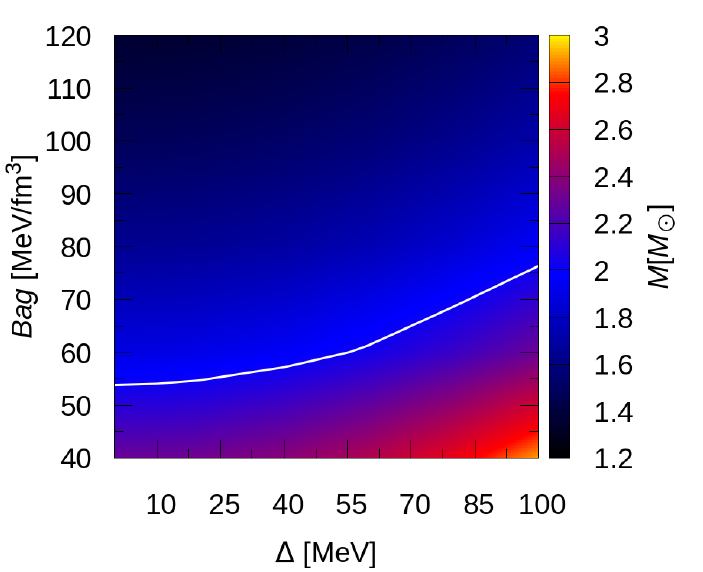
Figure 3. Maximum mass for each QS family, M max , in the Bag – ∆ plane considering the low MF parametrization. The white curve indicates the constraint of massive pulsars, M max = 2.01 M (cid:12) .